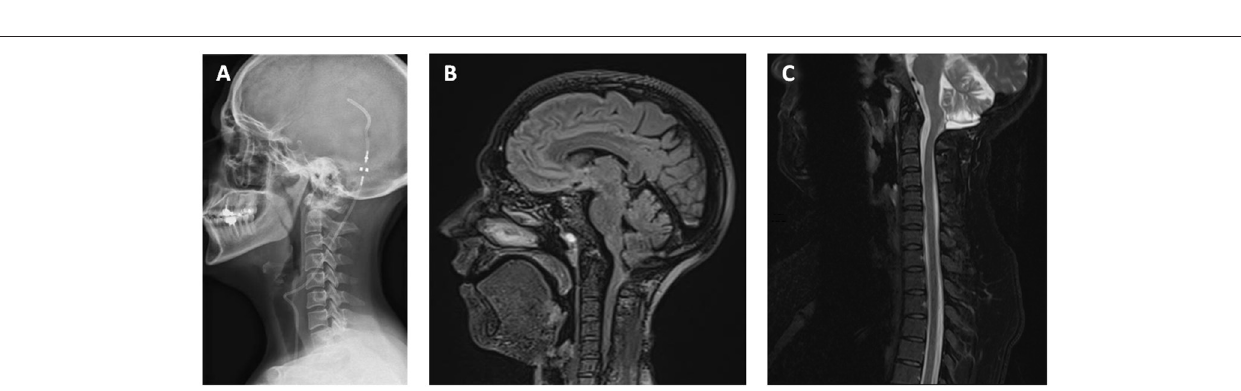
hemiparesis, permanent dizziness, and diffuse chronic